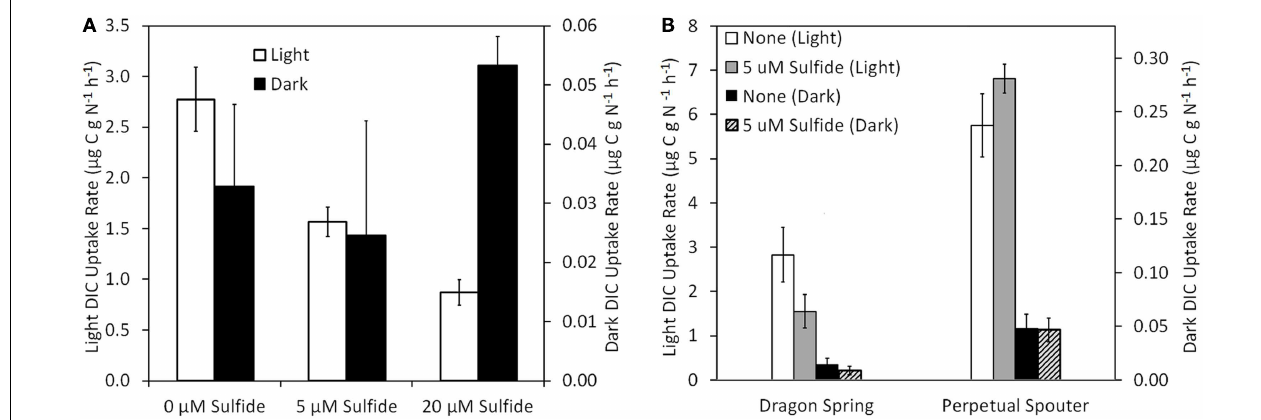
Temp. = 46.2˚C, total sulfide = ∼ 1 µ M) and Perpetual Spouter (fringe pH = 7.12,Temp. = 68.6˚C, total sulfide ≤ 150nM) as a function of amendment of sodium sulfide to final concentrations of 5 µ M when incubated under light and dark conditions (B) . All spring water used in inoculums was sampled from the photosynthetic fringe and rates of DIC uptake were normalized to grams of organic nitrogen present in the biomass used as inoculum ( Table 1 ).